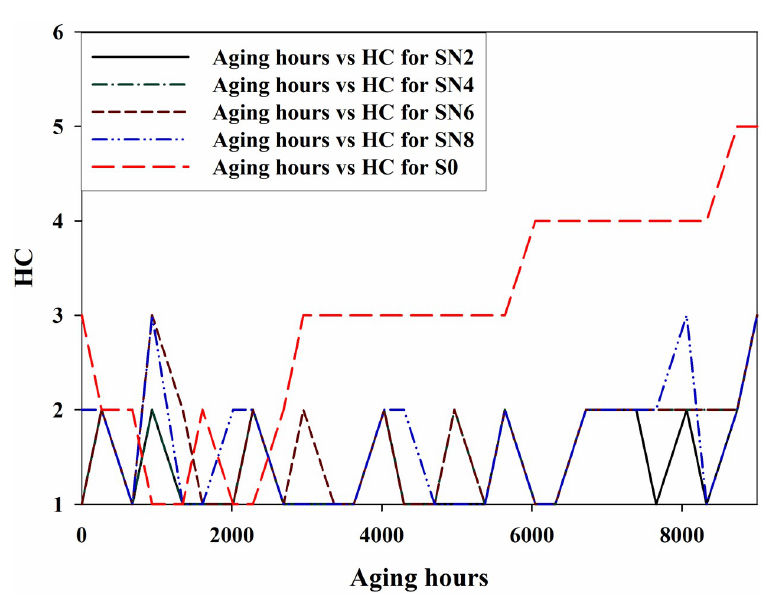
Fig 6. Silicone reaction mechanism with ozone.